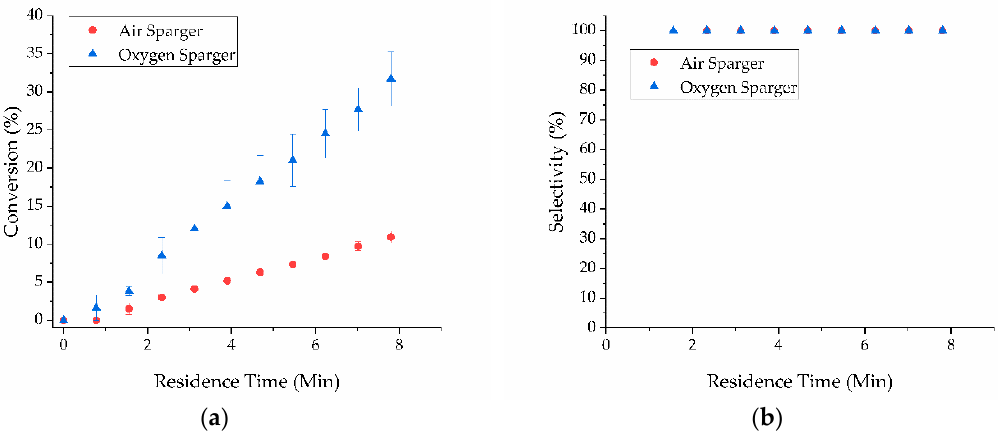
Figure 3. ( a ) Conversion of benzyl alcohol; ( b ) selectivity to benzaldehyde for the sparger modified X-Cube™ and external pump system for both air (red circles) and pure oxygen (blue triangles) at 2.8 bar.